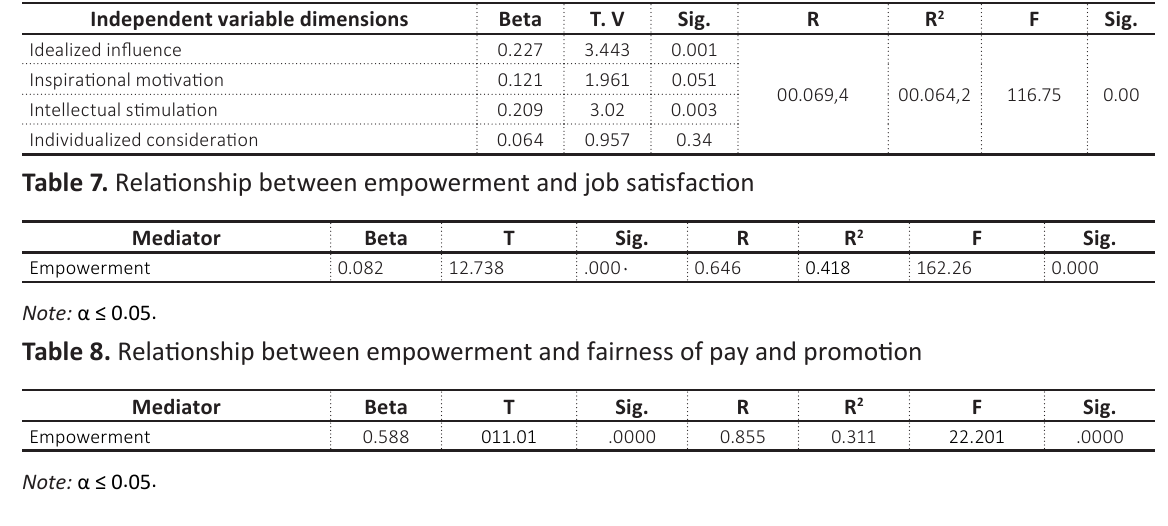
Table 6. Relationship between transformational leadership dimensions and empowerment